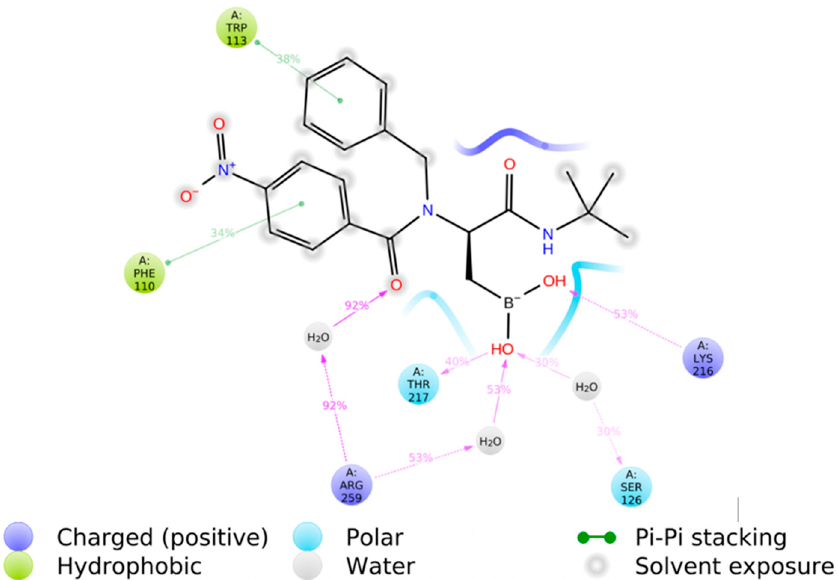
Figure 3. 2D representation of the predicted binding mode of compound 6e in the binding site of OXA-23 β -lactamase. Interactions that occurred for more than 30.0% of the simulation time in the selected trajectory (0.00 through 255.00 nsec), are shown. The picture was acquired by Maestro software.